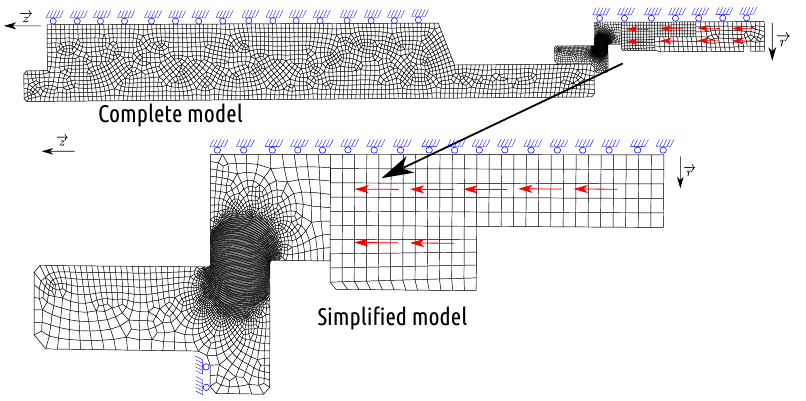
Figure 17. Complete dynamic shear model.